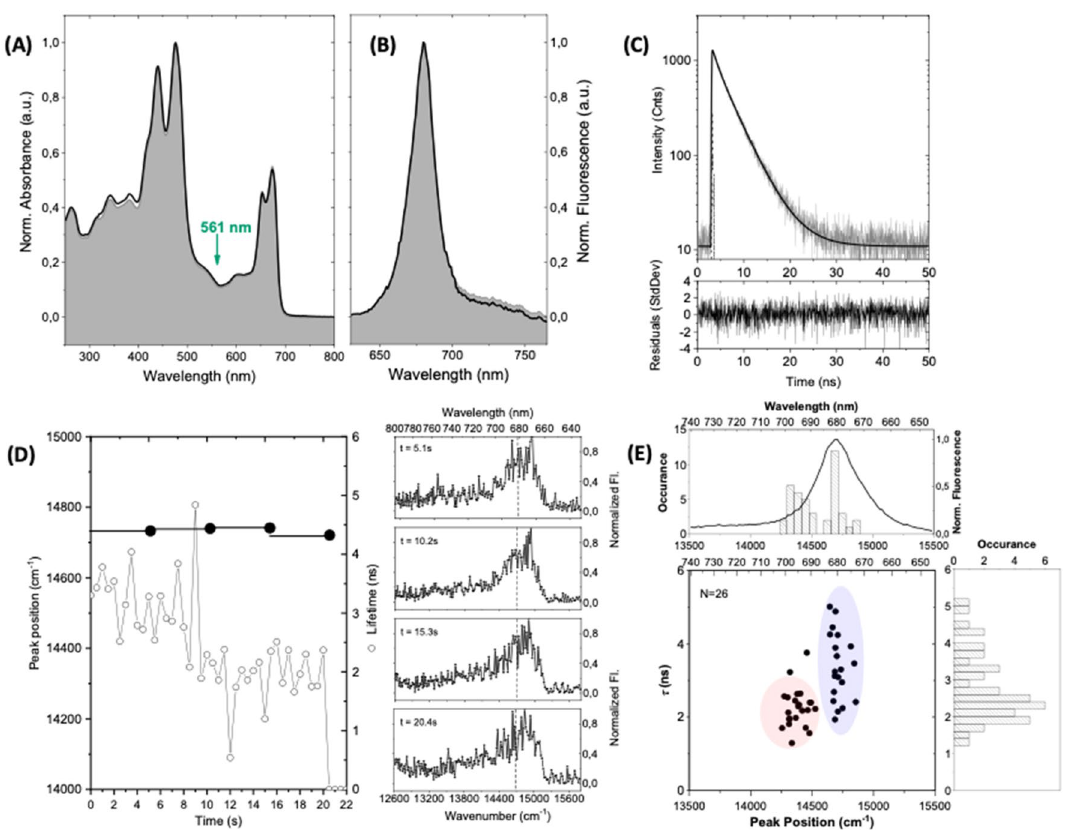
Figure 4. Spectroscopy on ensembles and single SCP complexes that have been stored for 7 months at − 80 °C in the dark. The samples for spectroscopy have been prepared in a cold room at 5 °C (protocol 3). ( A ) Room temperature absorption spectrum of an ensemble of SCP dissolved in bulk buffer solution at a concentration of 1.45 × 10 –7 M (black line). For comparison the corresponding absorption spectrum from the fresh sample (cf. Fig. 2A) has been underlaid as filled spectrum. Both spectra have been peak normalised at 476 nm. ( B ) Emission spectrum from SCP complexes embedded in PVA for an excitation intensity of 525 W/cm 2 . The filled area shows the emission spectrum from a sample of fresh SCP complexes embedded in PVA. Both spectra have been peak normalised for better comparison. The excitation wavelength for recording the emission spectrum was 561 nm as indicated by the green arrow in ( A ). ( C ) Fluorescence lifetime of an ensemble of SCP complexes immobilized in PVA in semi-logarithmic representation. The full line corresponds to a biexponential fit (see residuals at the bottom) with decay components (amplitudes) of 4.0 ns (79%) and 1.3 ns (21%). The excitation wavelength is 561 nm, and the excitation intensity amounts to 525 W/cm 2 . ( D ) Fluorescence lifetimes and spectral peak positions of a single SCP complex. The fluorescence lifetime (scale on the right) was read out every 500 ms and is given by the open dots. The bin time for recording the spectra was 5.1 s (full line) and the observed spectral peak position of the accumulated spectrum is given by the black dot (scale on the left). The sequence of emission spectra is shown on the right-hand side from top to bottom. For better comparison, the broken vertical line refers to the spectral peak position of the ensemble emission spectrum. ( E ) Two- dimensional representation of the fluorescence lifetime vs. spectral peak position of individual SCP complexes. Due to fluctuations of both lifetime and/or spectral peak position a single complex can contribute more than one data point to the diagram. For the distinction between the data points in the red and blue shaded areas see text. The number of individual complexes that contribute to the pattern is given in the top left corner. The histograms correspond to the distributions of the spectral peak position (top) and fluorescence lifetime (right). For ease of comparison an emission spectrum from a sample of fresh SCP complexes embedded in PVA has been overlaid in the top histogram. The statistical parameters of the two histograms (mean ± sdev) are (14,537 ± 181) cm −1 for the peak positions, and (2.8 ± 0.9) ns for the lifetimes,